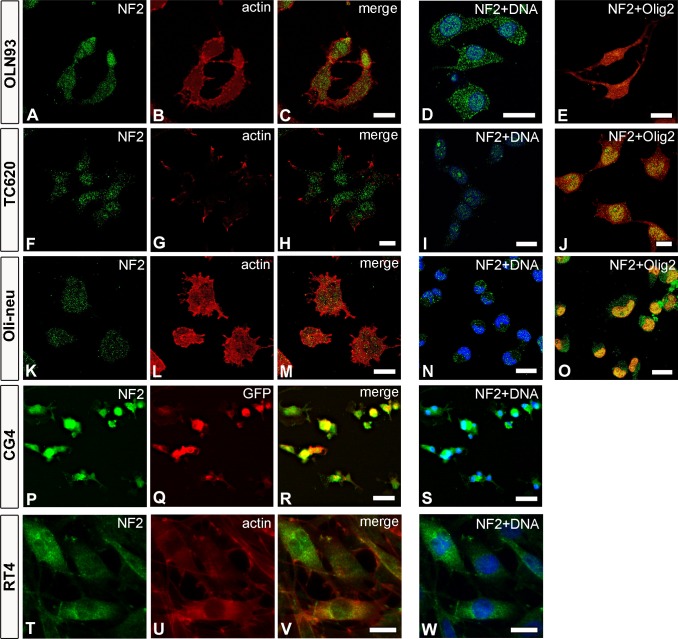
Expression and localization of Merlin in oligodendrocytes.Merlin (NF2) expression is demonstrated by immunostaining and visualized in green color in all cultured cells. Images in A-O represent confocal images of a single plane (using a 63x objective and 1 Airy Unit pinhole size), while oligodendrocyte primary cultures and RT4 cells were taken as epifluorescent images (P-W). Cells were counterstained with phalloidin (B, G, L, U), GFP to show NG2-positive cells (Q), DRAQ5 (D, I, N), Hoechst 34580 (S, W) and Olig2 (E, J, O). Scale bars: 20μm.